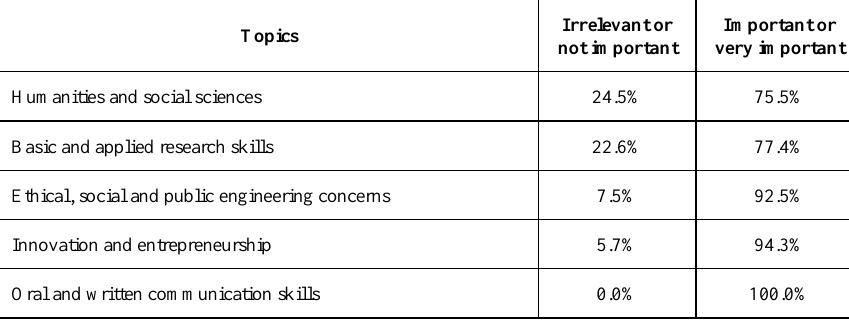
Table 3. Relevant topics in engineering